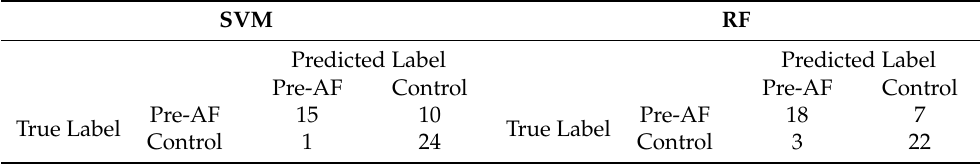
Table 6. Confusion matrix on the test data (5 min before